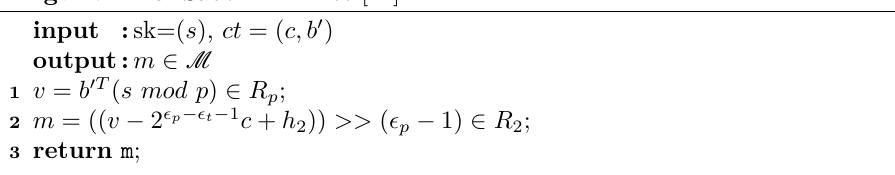
Algorithm 3: Saber.PKE.Dec